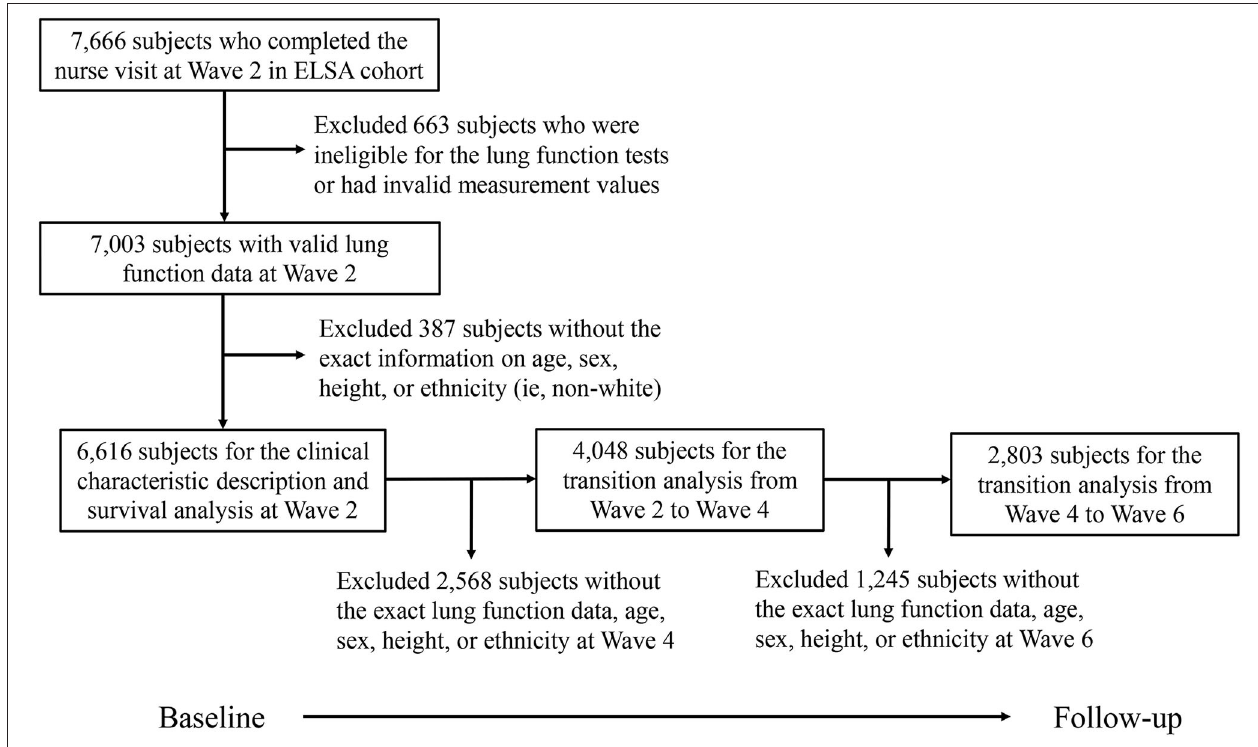
FIGURE 1 | Flowchart of the study population selection procedure. ELSA, English longitudinal study of